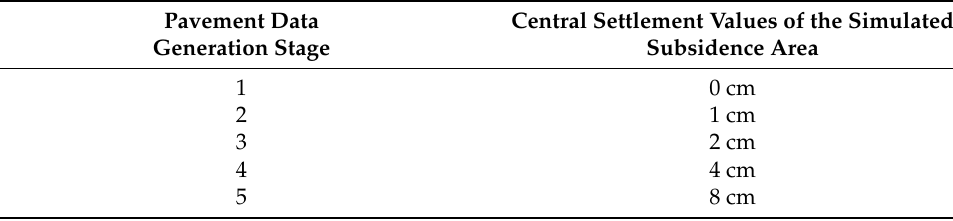
Table 1. Central settlement values of the simulated subsidence area. Pavement Data Central Settlement Values of the Simulated Subsidence Area Generation Stage 1 0 cm